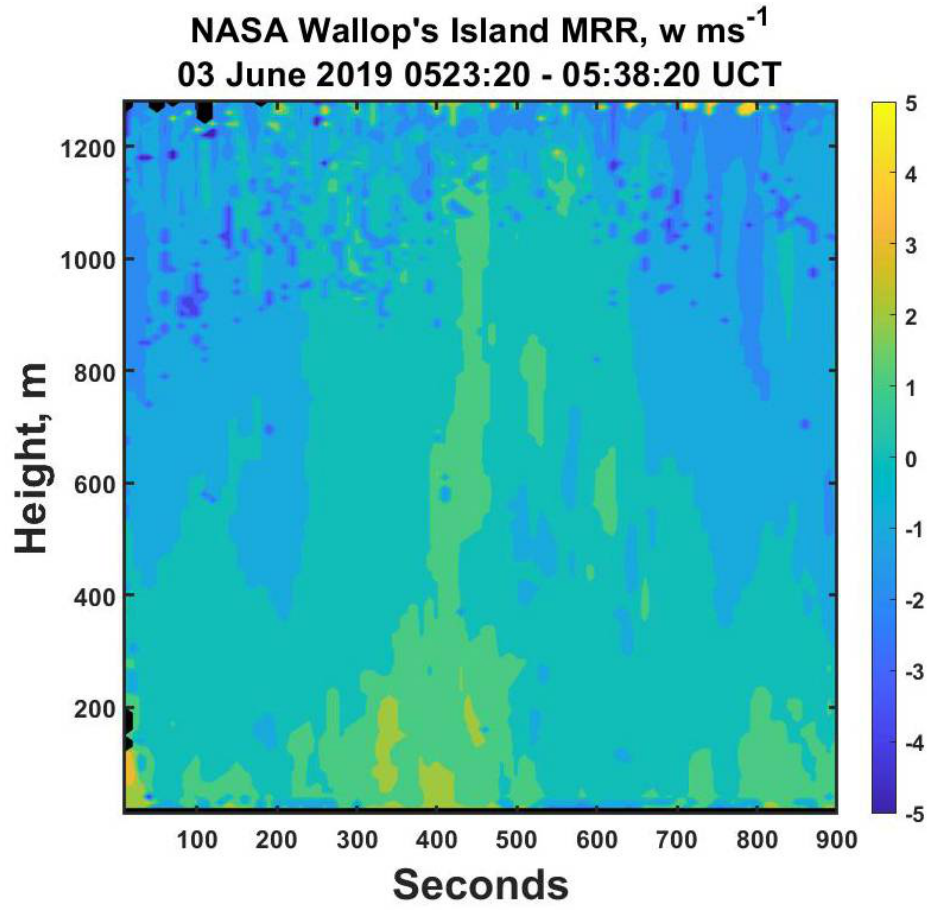
Figure 12. The air vertical velocities, w , derived using the approach described in the text. Note the coherent temporal and spatial structure of the winds with weak updrafts and downdrafts in the center and stronger downdrafts on each side. The velocity magnitudes are also consistent with the observations of others elsewhere, as discussed in the text.